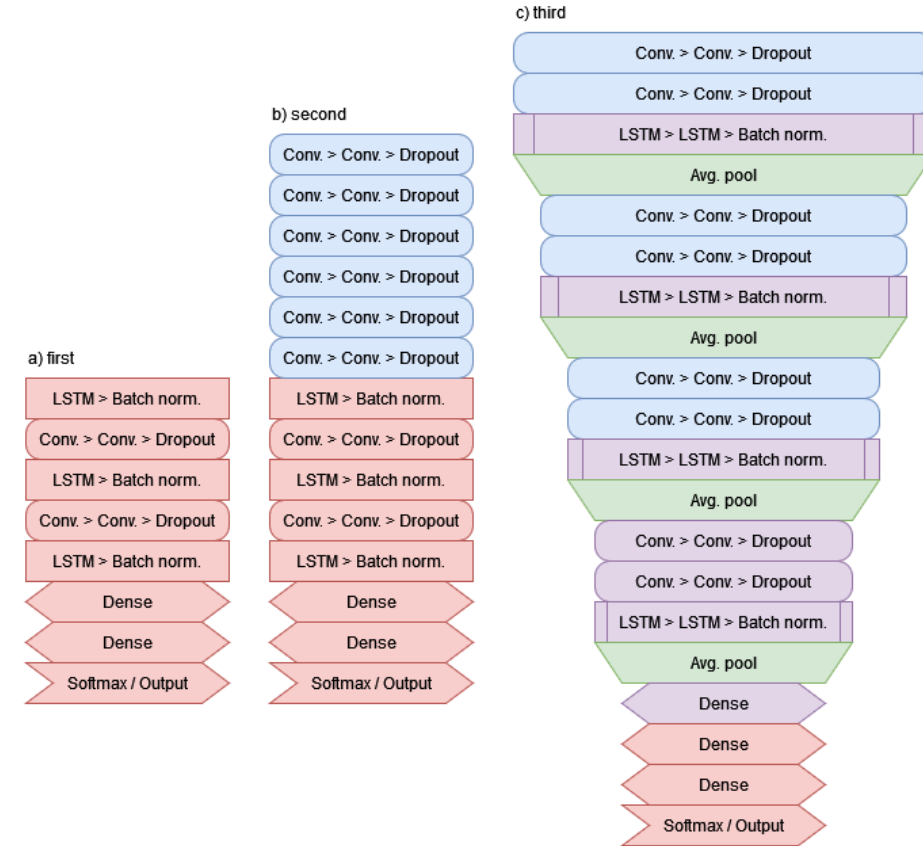
Figure 5. Diagrams of the three model variants used in the research. ( a ) Initial model. ( b ) Upgraded initial model with changes colored blue. ( c ) Most complex model. The purple color shows improve- ments to the parts of ( a , b ) models with additional layers. The green color is an addition to a new type of